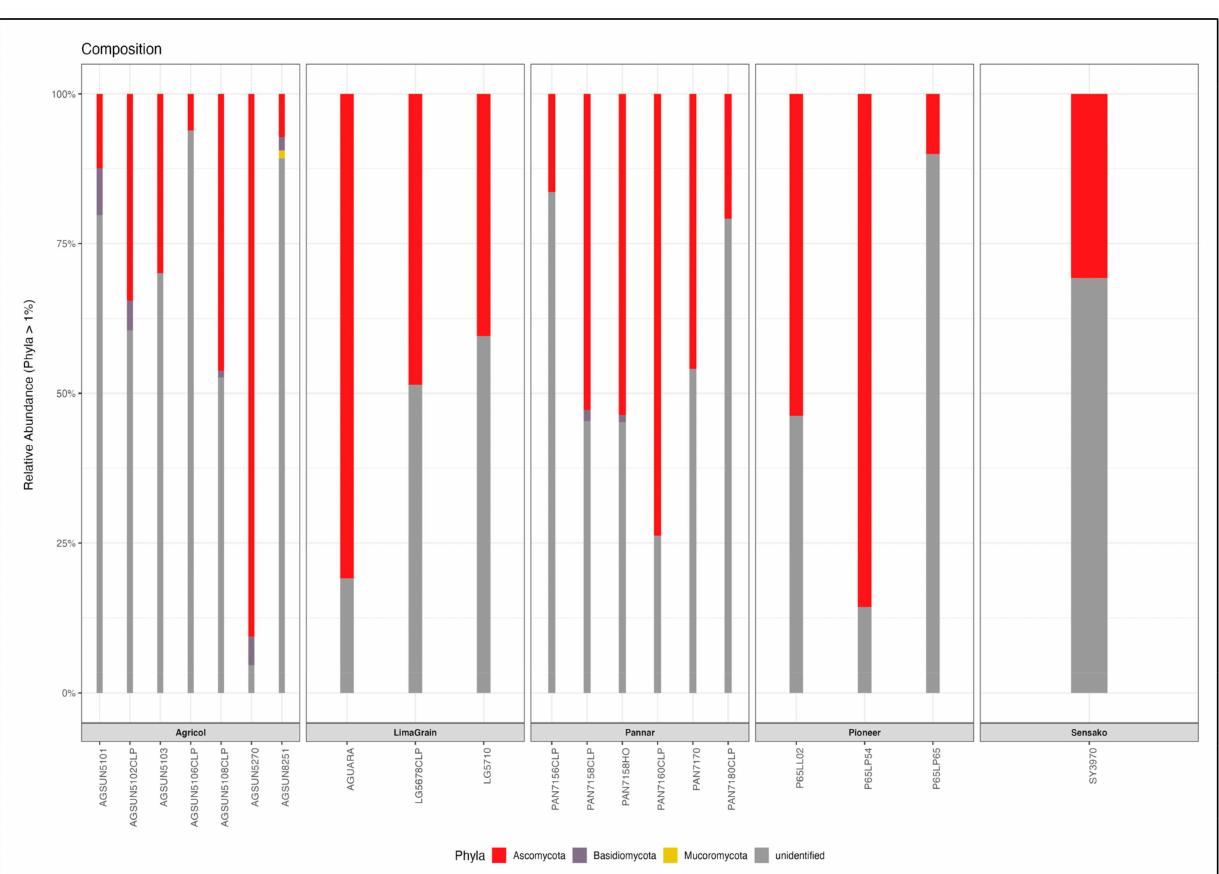
Figure 4. Relative abundance of the dominant fungi Phyla from different cultivars of South Africa H. annus